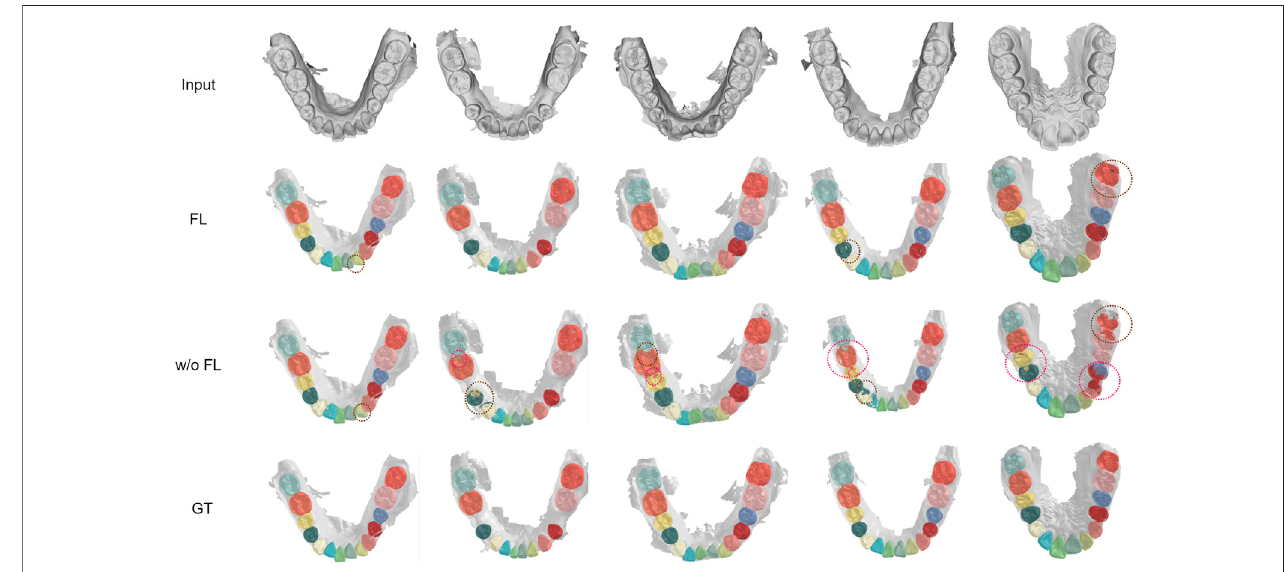
FIGURE 6 | Visualization of segmentation results under imbalanced distribution with FedTSeg and without FedTSeg. Some distinct errors are annotated with dotted circles.